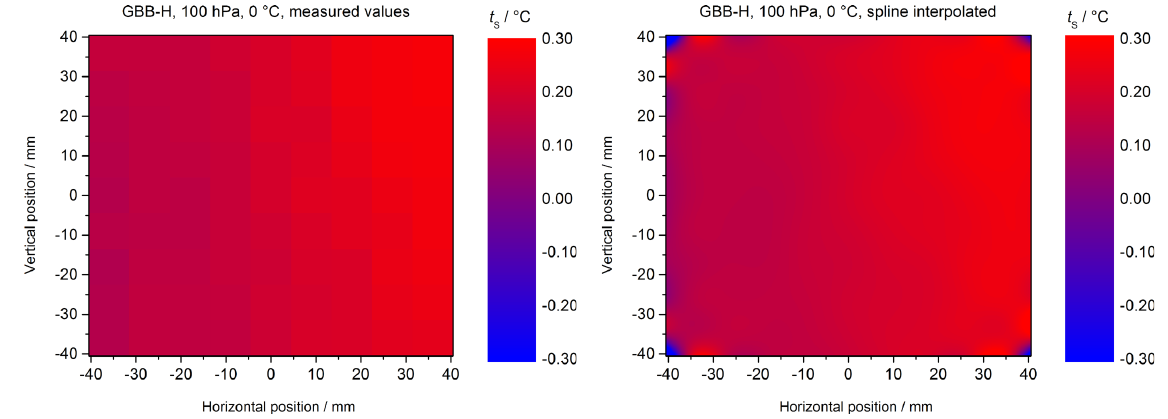
Fig. 18. The spectrally resolved radiation temperature of the GBB-H measured with the vacuum FTS at 0 ◦ C and three different positions on the optical surface. The respective ranges of the measurement uncertainty are depicted as shaded areas. The three measurement areas on the optical surface of the GBB-H are shown as circles in the inset. www.jn.net/1/1/2013/